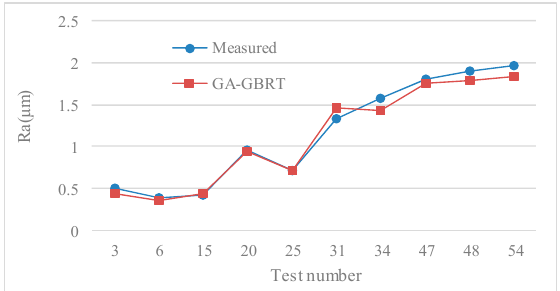
Figure 8. Prediction results of genetic-gradient boosting regression tree (GA-GBRT).